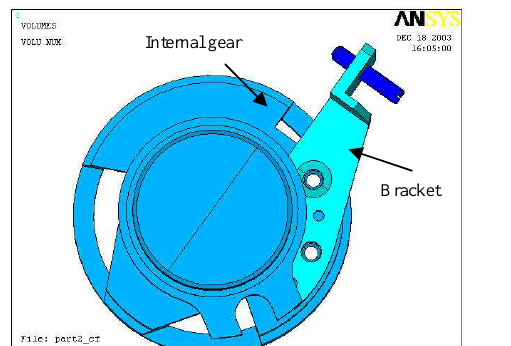
Fig.2. Overall view of rotation mechanism